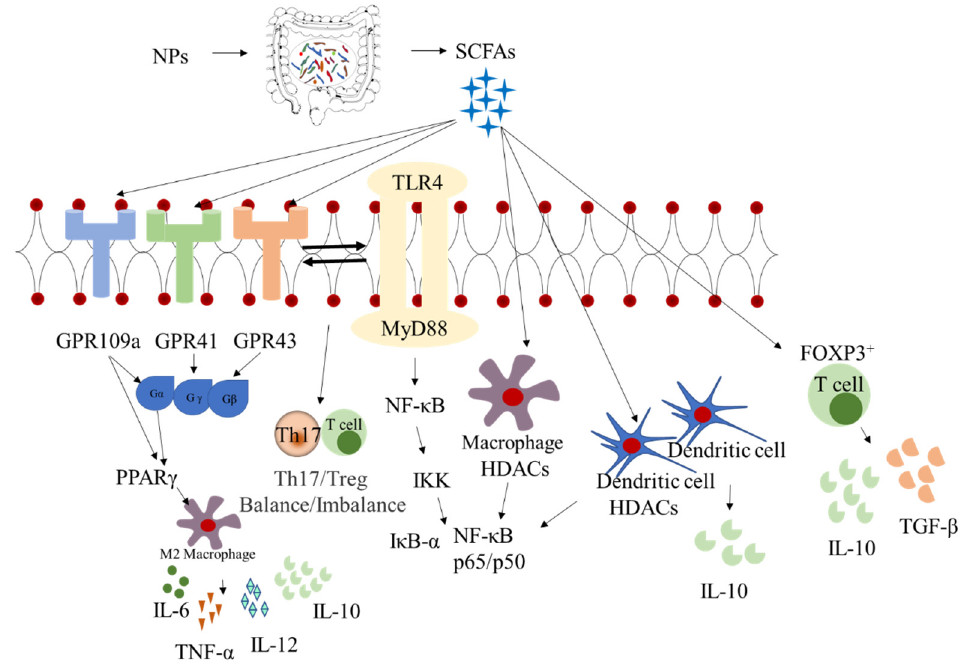
Figure 2. Effects of short-chain fatty acids (SCFAs) produced by intestinal microbiota on inflammatory bowel disease (IBD). HDAC: histone deacetylases; NF- κ B: nuclear factor kappa B; GPR41: G protein coupled receptor 41; GPR43: G protein coupled receptor 43; GPR109a: G protein-coupled receptor 109 a; PPAR: peroxisome proliferator-activated receptors; TLR 4: Toll-like receptor